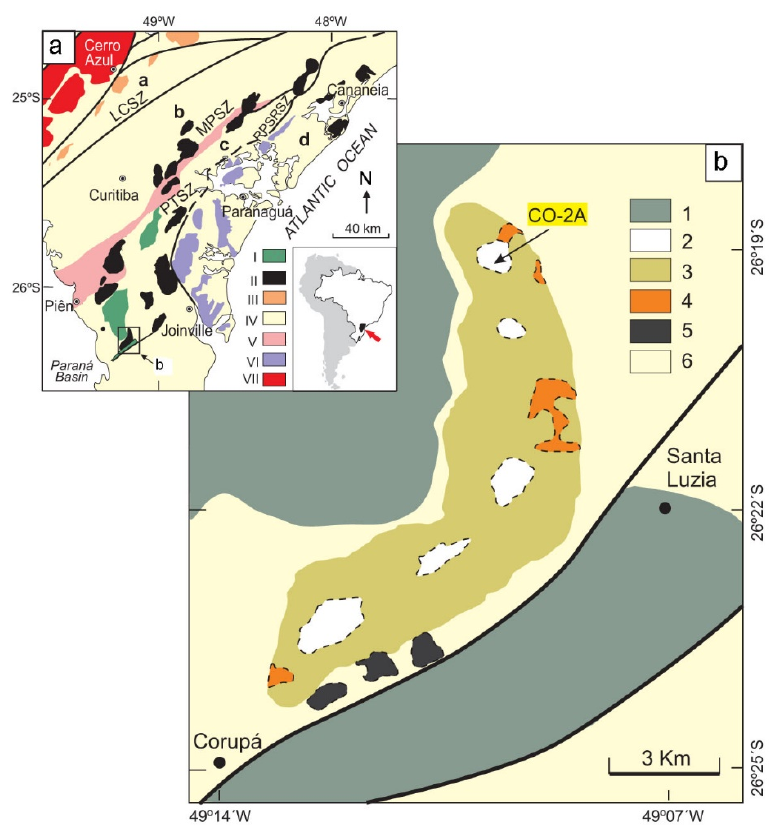
Figure 1. Simplified geological context ( a ) and map of the Corupá Pluton ( b ), Southern Brazil [25,32–34]. ( a ): I: Volcano-sedimentary basins; II: “A-type” granitic and syenitic plutons and complexes from the Graciosa Province; III: “A-type” granitic plutons from the Itu Province; IV. A: Ribeira fold belt; b: Curitiba microplate; c: Luiz Alves microplate; d: Coastal granitoid belt. V: Piên-Mandirutuba Granite batholith; VI: Undifferentiated late- to post-collisional granites; VII: Três Córregos batholith. LCSZ: Lancinha Shear Zone; RPSRSZ: Rio Palmital-Serrinha Shear Zone. ( b ): 1: Sedimentary and volcanic rocks from Guaratubinha Basin (above) and Corupá Graben (below); 2: Alkali-feldspar granites, 3: Alkali-feldspar syenites, 4: Gabbro-diorites and related hybrid rocks, 5: Basic volcanics, 6: Archaean granulitic rocks from the Luis Alves microplate. The location of the studied CO-2A sample is indicated.